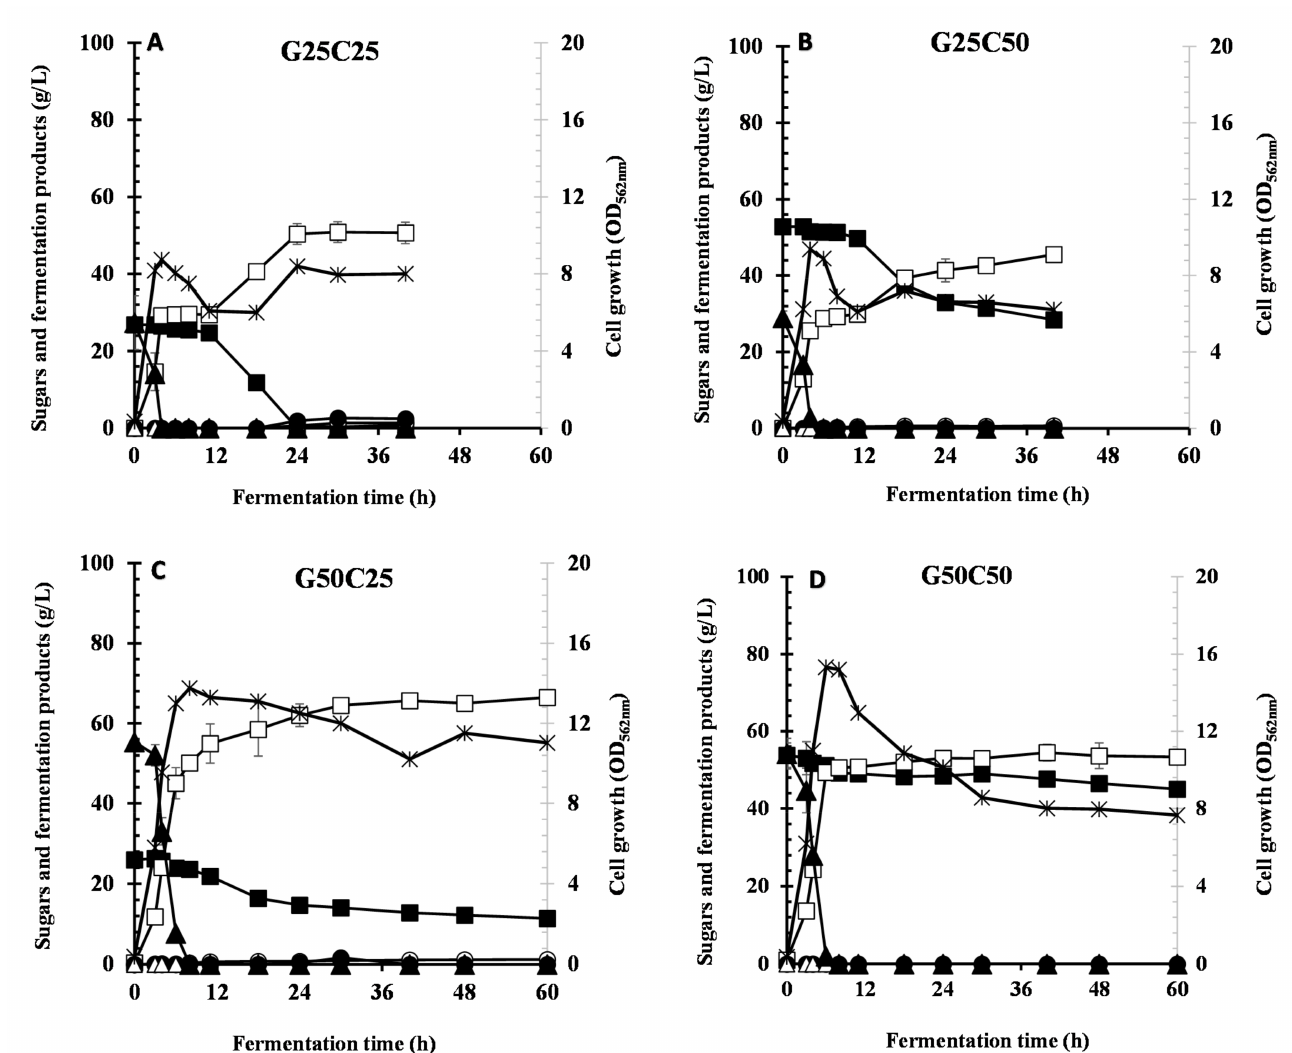
Figure 3. Effect of different glucose/cellobiose concentrations on growth and lactic acid production by B. coagulans Azu-10. ( A ) fermentation of 25 g/L glucose and 25 g/L cellobiose [G25C25]; ( B ) fermentation of 25 g/L glucose and 50 g/L cellobiose [G25C50]; ( C ) fermentation of 50 g/L glucose and 25 g/L cellobiose [G50C25]; ( D ) fermentation of 50 g/L glucose and 50 g/L cellobiose [G50C50]. Symbols: (cid:4) , cellobiose (g/L); (cid:78) , glucose (g/L); (cid:3) , lactic acid (g/L); formic acid (g/L); ∆ , ethanol (g/L); *, growth (OD 562 nm